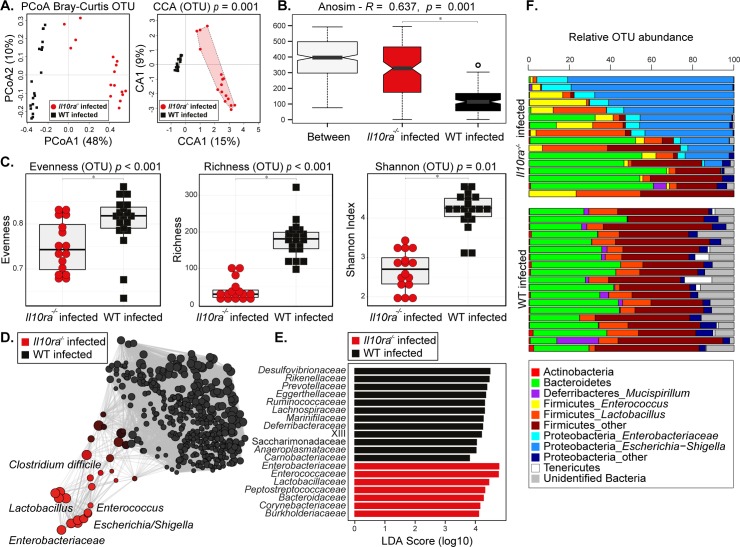
Caecal dysbiosis upon whipworm infection and defective IL-10 signalling is associated with expanded populations of pathobionts.Caecal microbial community structure at the operational taxonomic unit (OTU) level of co-housed T. muris-infected (high dose, 400 eggs) six-wk-old female and male littermate WT and Il10ra-/- mice at day of culling. (A) Principal Coordinates Analysis (PCoA) and Canonical Correspondence Analysis (CCA p = 0.001), the numbers in brackets indicate the percentage variance explained by that component. (B) beta-diversity index (ANOSIM R = 0.637 and p = 0.001), (C) alpha-diversity indexes (Shannon diversity, richness and evenness; ANOVA p = 0.01, p<0.001, p<0.001, respectively), (D) network analysis, (E) Linear Discriminant Analysis Effect Size (LEfSe) analysis and (F) bar plots representing proportional abundance of individual OTUs in caecal microbial community structures. Data from two independent replicas. WT n = 19. Il10ra-/- n = 16.